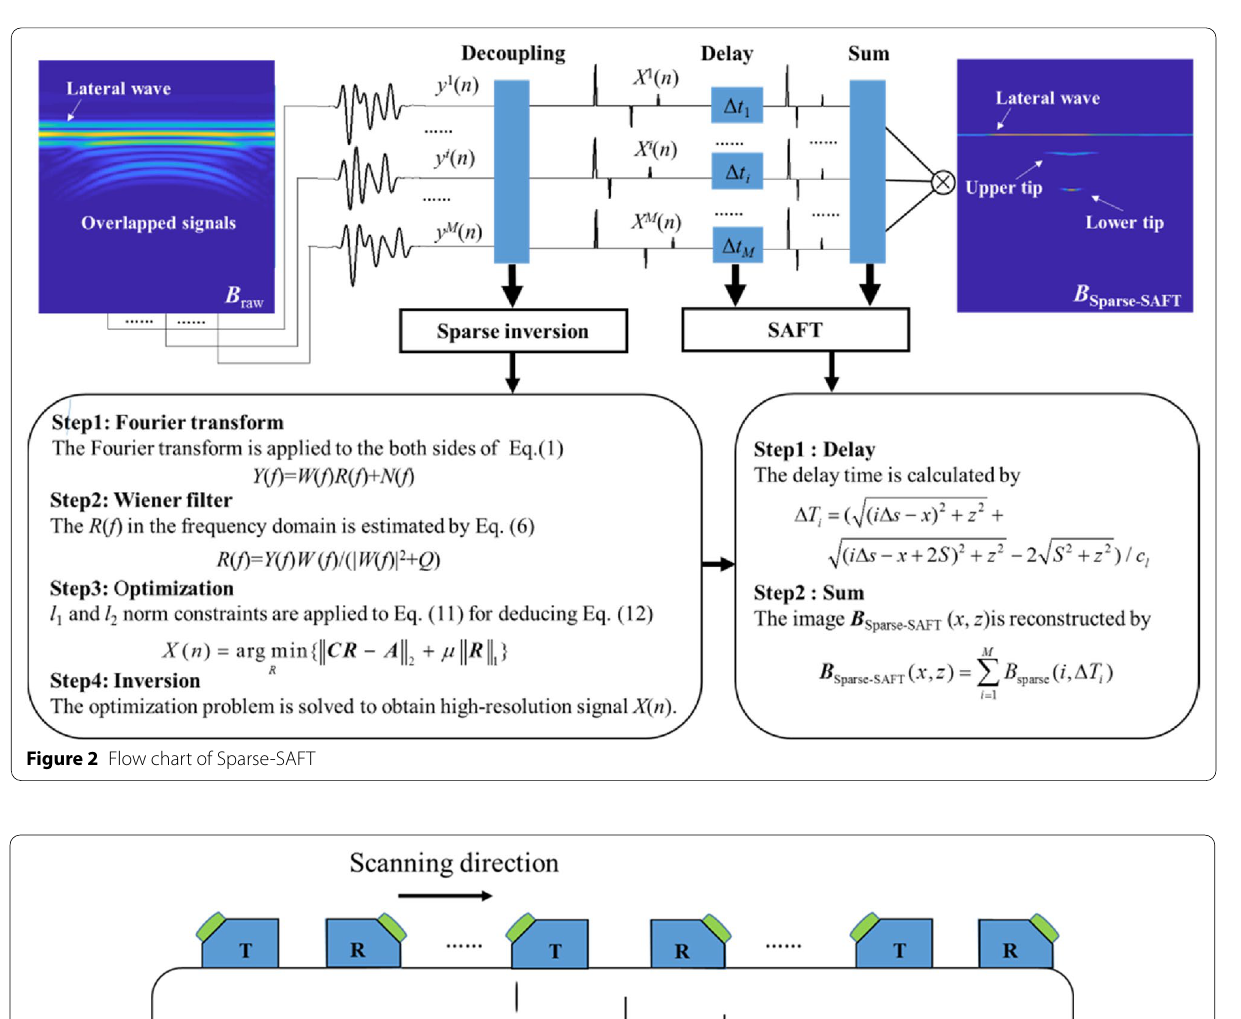
Figure 3 Schematic diagram of detecting shallow subsurface cracks with ultrasonic